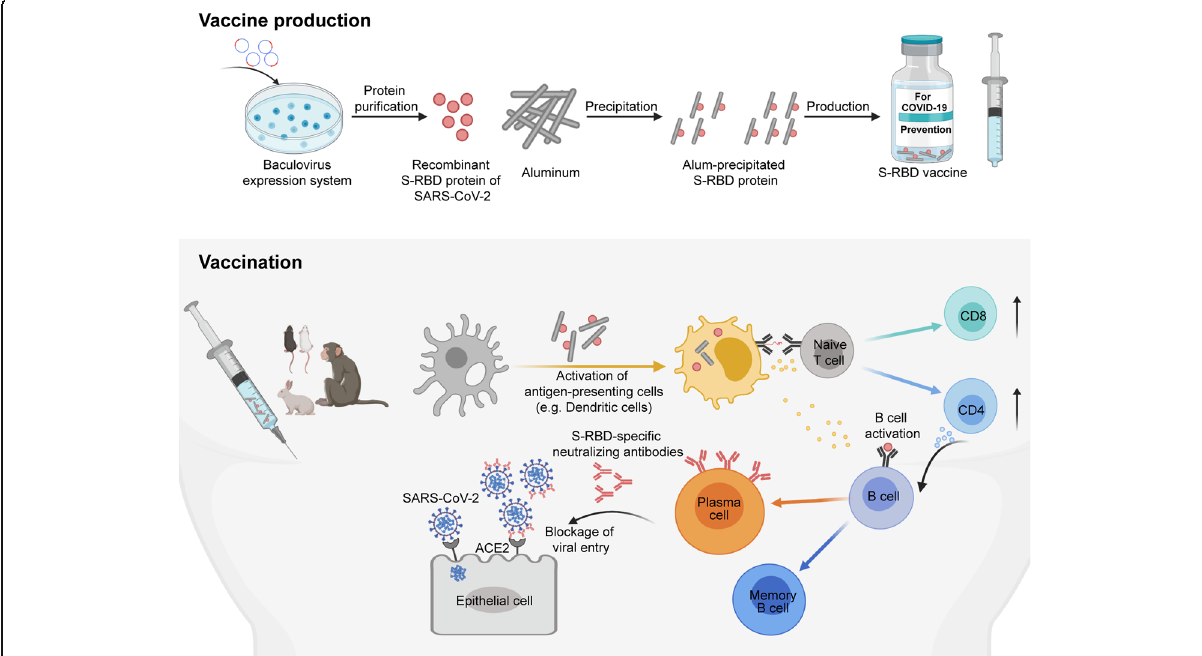
Fig. 1 Scheme of generating and evaluating the vaccine candidate targeting the spike protein receptor binding domain (S-RBD) of SARS-CoV-2. The recombinant S-RBD protein comprising residues 319 – 545 was generated at a massive scale using a Bac-to-Bac baculovirus expression system, followed by precipitation with aluminum (alum). The alum-precipitated S-RBD vaccine was then administrated into mice, rabbits or non-human primates. The vaccine components are taken by antigen-presenting cells (APCs), and then induce the activation and maturation of APCs. The activated APCs prime and drive naïve T cells differentiation into effector cells, including CD4 helper and CD8 T cells. Meanwhile, the resting B cells directly recognize the S-RBD protein and then differentiate into antigen-specific plasma cells and memory B cells under the cytokine support from APCs and helper T cells. The S-RBD vaccine can induce abundant S-RBD-specific neutralizing antibodies secreted from the plasma cells and effectively prevent live SARS-CoV-2 infection by blocking viral